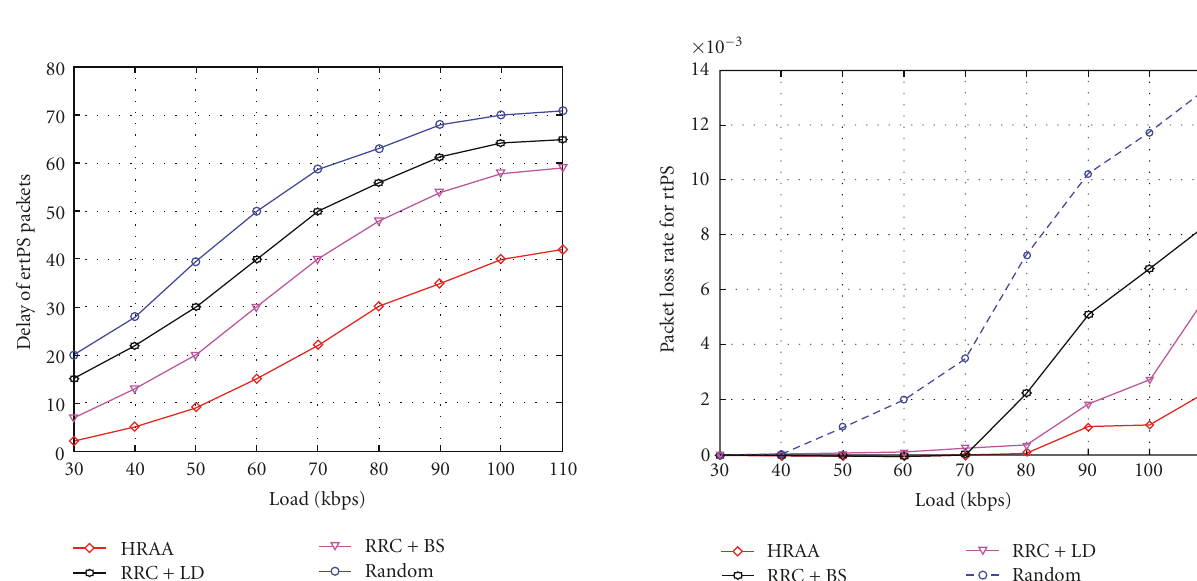
each BS uses the bigger is the average cell throughput. In